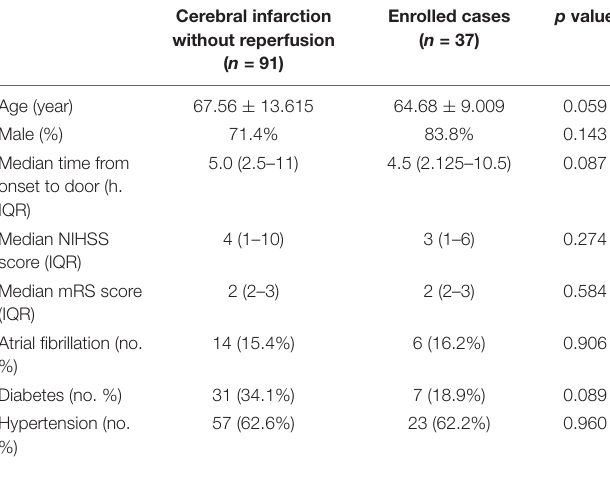
TABLE 1 | Baseline characteristics of enrolled cases and cerebral infarction without reperfusion in